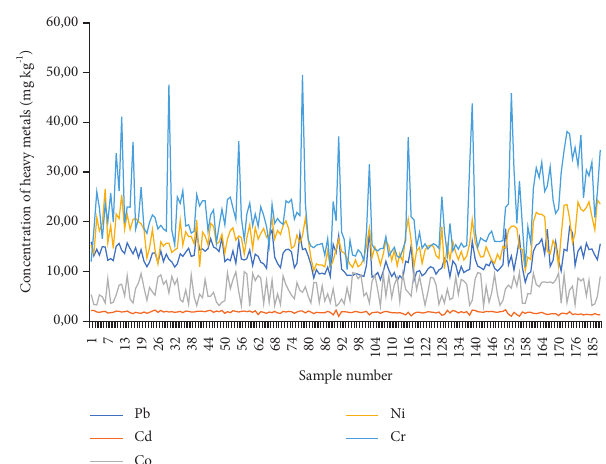
Figure 2: Heavy metal concentrations of the soil samples taken in the shallot fields in Brebes Regency, Central Java,